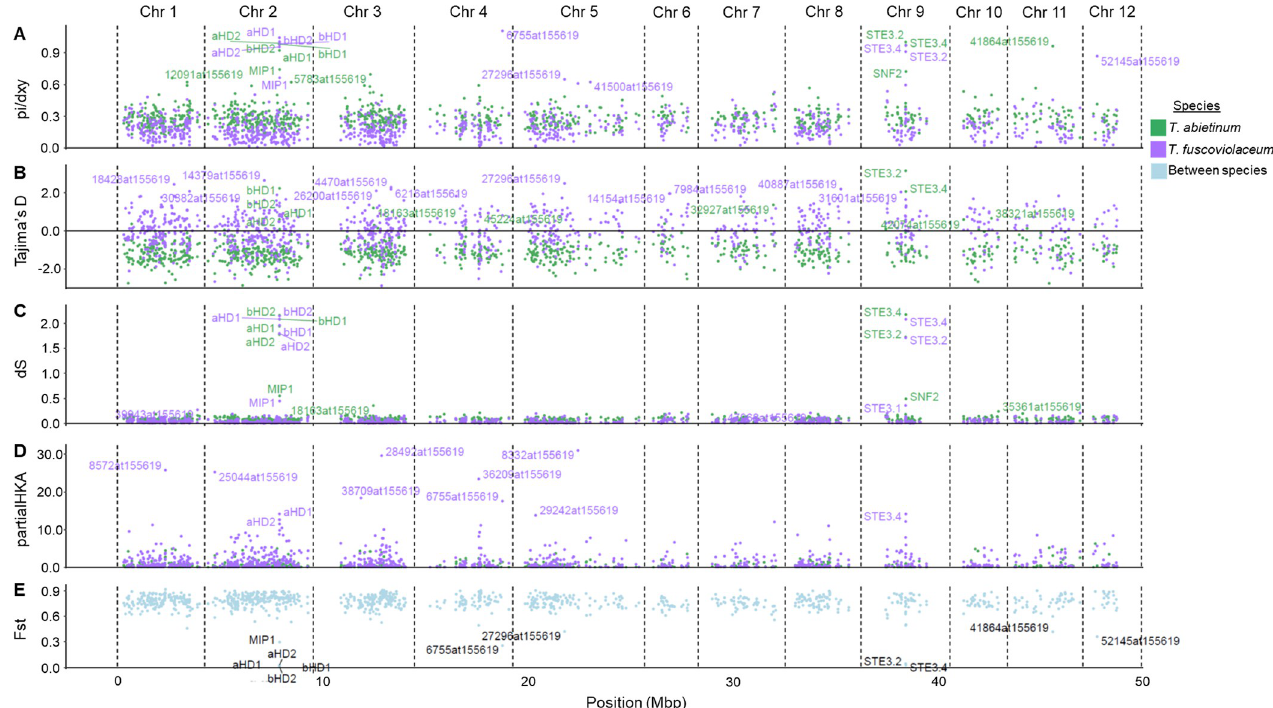
Fig 8. Multiple nucleotide statistics support long-term balancing selection in genes located in the mating region. Ratio of nucleotide diversity (Pi) and absolute divergence (dxy), Tajima’s D, average number of synonymous substitutions per synonymous sites (dS), and relative divergence (Fst) values for each single-copy orthologous and mating genes are reported in panels A), B), C) and E), respectively. Gene contribution to the significance of a HKA test (partial HKA) are represented in panel D). Gene names containing 1% of the highest values (panels A, B, C, and D) or 1% of the lowest values (panels E and F) are displayed. T . fuscoviolaceum gene names with the highest partial HKA values are displayed due to the significant result of the HKA test ( p -value = 3.13 x 10 − 39 ). Each dot represents a gene and we used the annotation in T . abietinum to represent the position of each gene. Annotation file can be found in the Github page dedicated to this project. Dots were colored according to within species calculations (green or purple for T . abietinum and T . fuscoviolaceum , respectively) or between species comparison (cyan). Chr: chromosome. These analyses include all strains from both species.